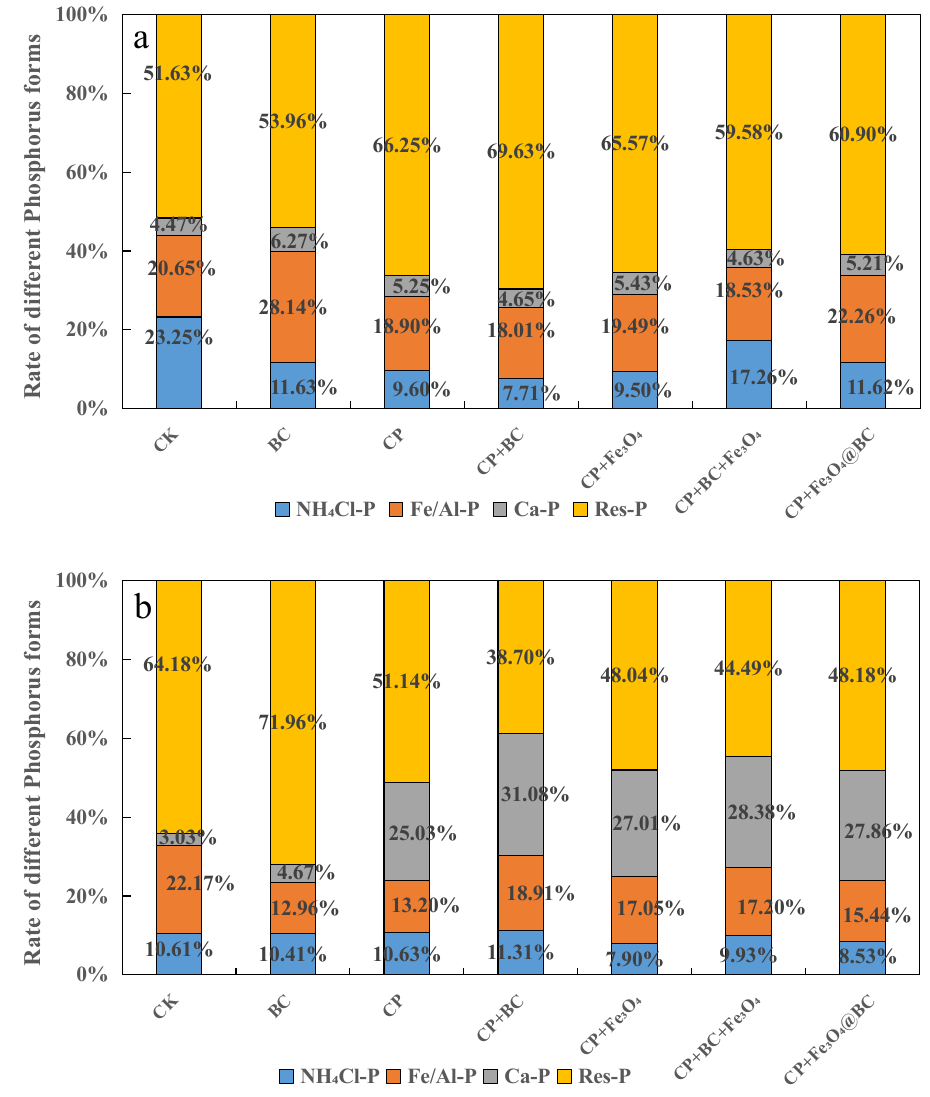
Figure 6. The variation of P in different forms in sediments: ( a ) the 2nd day. ( b ) the 8th day.